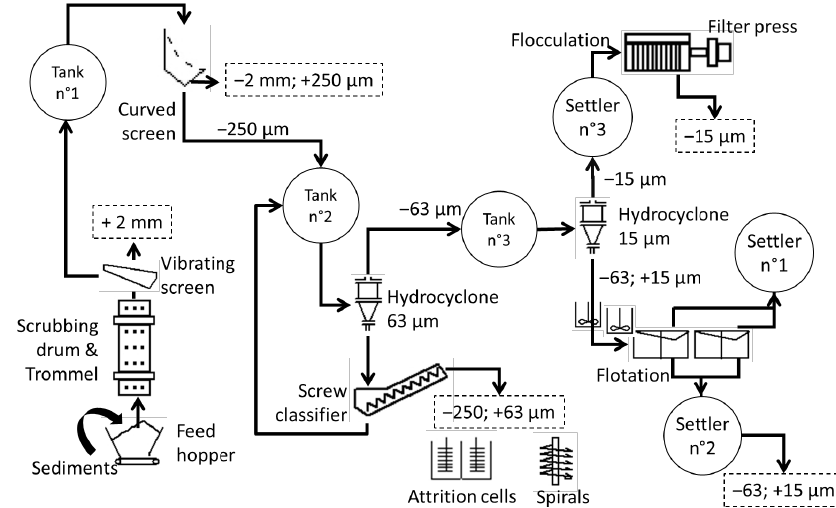
Figure 6. General scheme of the SOLINDUS pilot platform.